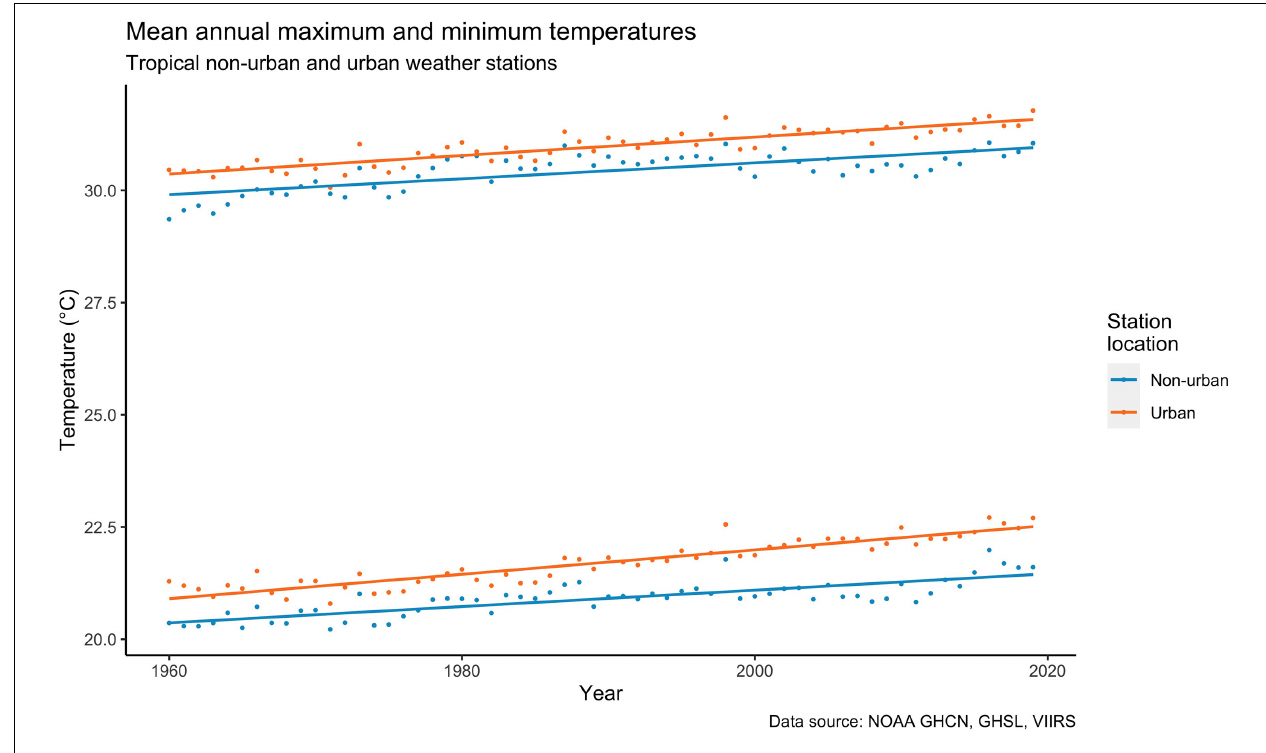
FIGURE 7 | Mean annual maximum and minimum temperatures in tropical urban and non-urban areas. The higher points and curves on each mini-plot represent the maximum temperatures and the lower points and curves represent the minimum temperatures. Data source: NOAA,